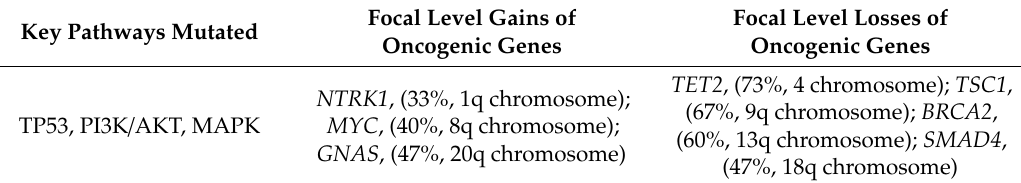
Table 2. Somatic copy number variations in key pathways and oncogenic genes in 15 Korean OCCC